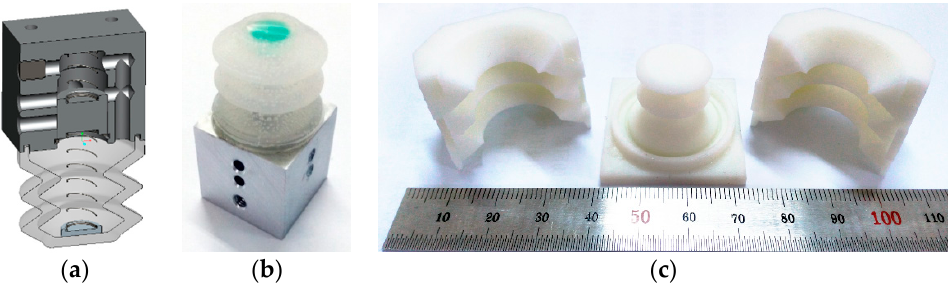
Figure 7. The PVSU. ( a ) The sectional view of the PVSU; ( b ) the prototype of the PVSU; and ( c ) the molds developed for the pneumatic bladder.